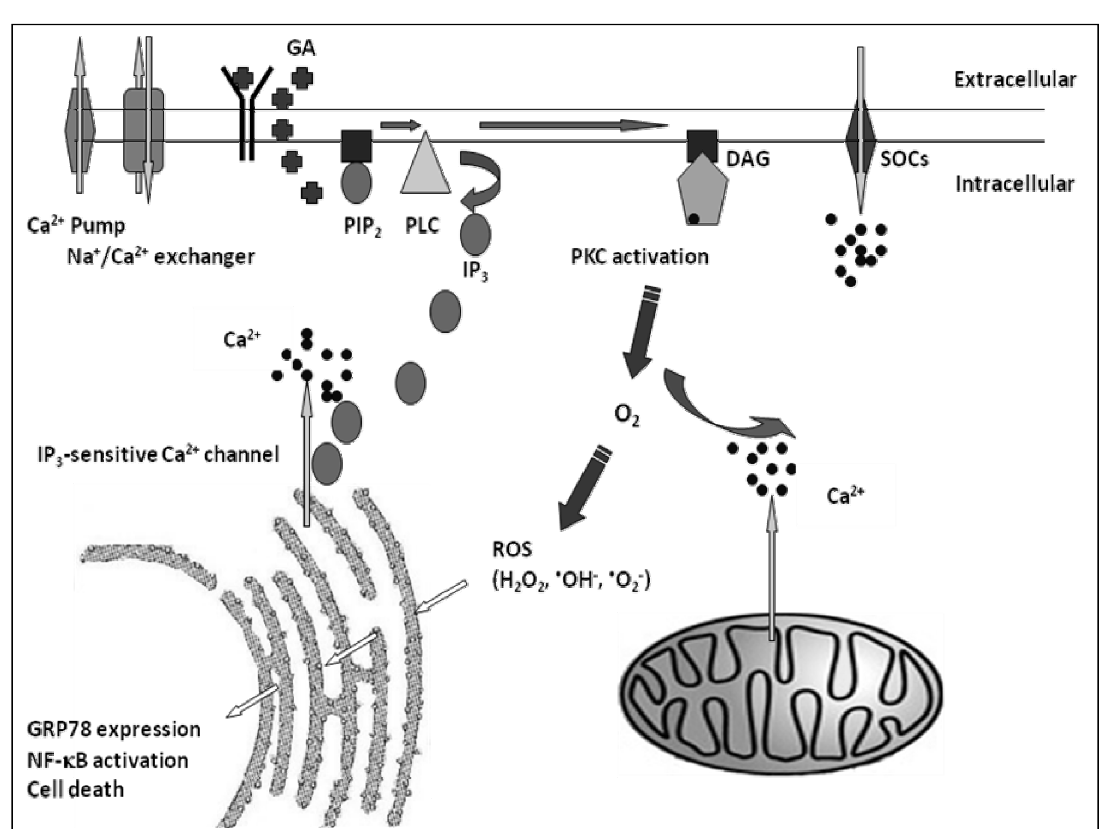
Figure 5. Model of GRP78 induction by calcium, PKC and ROS, following GA stimulation. DAG, diacyl glycerol; IP , inositol 3